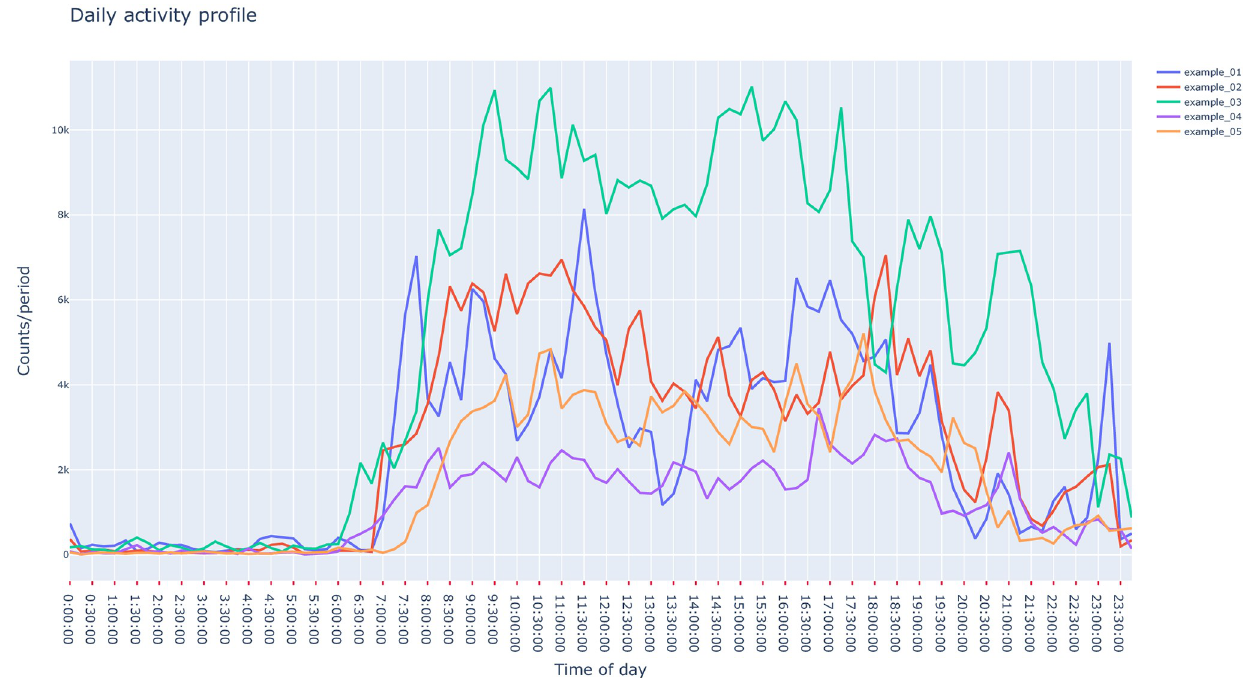
Fig 2. Visualization example of average daily profiles obtained with pyActigraphy using example files included in the package.